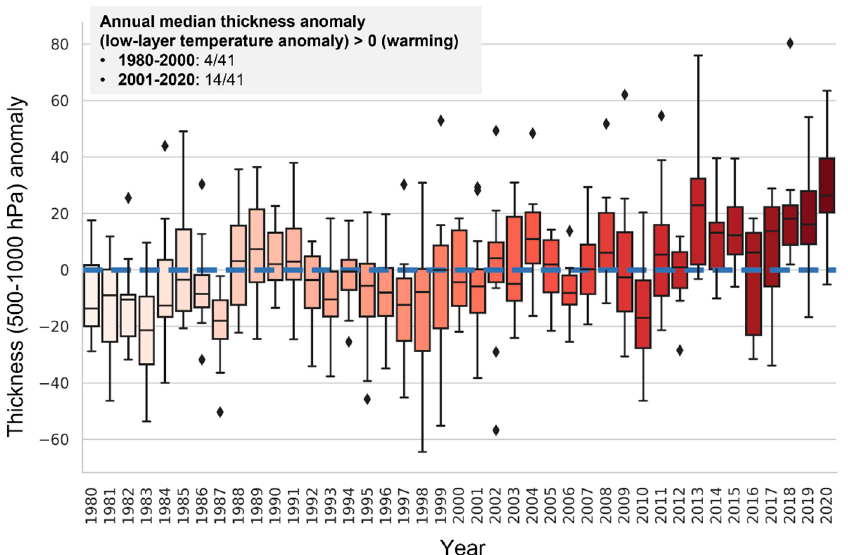
Figure 9. The box-and-whisker plots of the atmospheric layer thickness (500–1000 hPa) anomaly averaged over the eastern Pacific and western U.S. (160–100° W and 30–50° N) from 1980 to 2020 obtained from MERRA2 data. The error bar represents the data within a 95% confidence interval per year. The boxplot’s interior line indicates the median for given year; the bottom and top of the boxes are the 25th and 75th percentiles; the upper extreme and the lower extreme whiskers represent the maximum and minimum data. The black dot outside the box indicates the outlier.